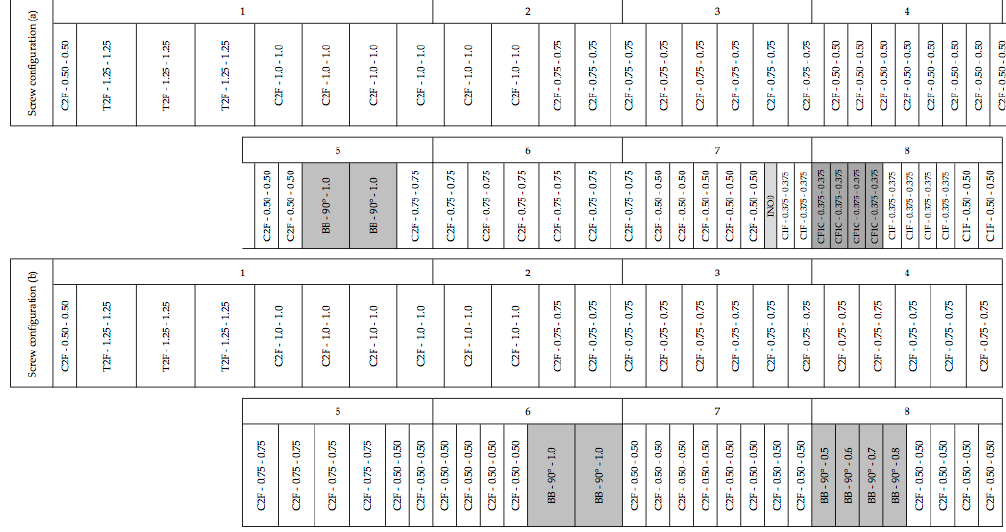
Figure 5. Screw configuration ( a ) for the coriander straw fiber refining process and screw configuration ( b ) for the raw material premixing operation, using a Clextral Evolum HT 53 twin-screw extruder. T2F, trapezoidal double-flight screws; C2F, conjugated double-flight screws; C1F, conjugated single-flight screws; CF1C, conjugated cut-flight, single-flight screws with left-handed pitch; BB bilobe paddles; INO0 linking element between double- and single-flight screws. The two numbers following the type of screw element indicate respectively the pitch and length of T2F, C2F, C1F and CF1C screws. The two numbers following the BB mixing blocks represent respectively the staggering angle and length. Shaded areas represent flow-restricting zones in the screw configuration.